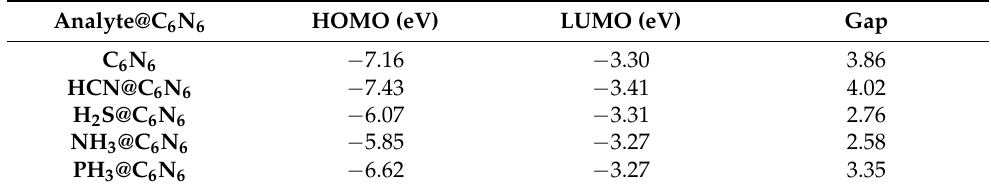
Table 3. The energies of the HOMO, LUMO and HOMO–LUMO energy gap (EH–L gap) of analyte@C 6 N 6